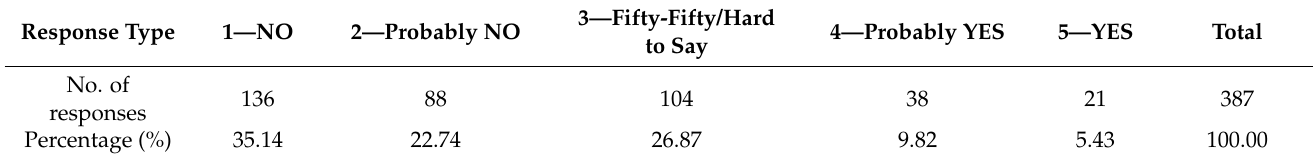
Table 4. Responses to the fourth question: Would you be inclined to buy a digital work of art?